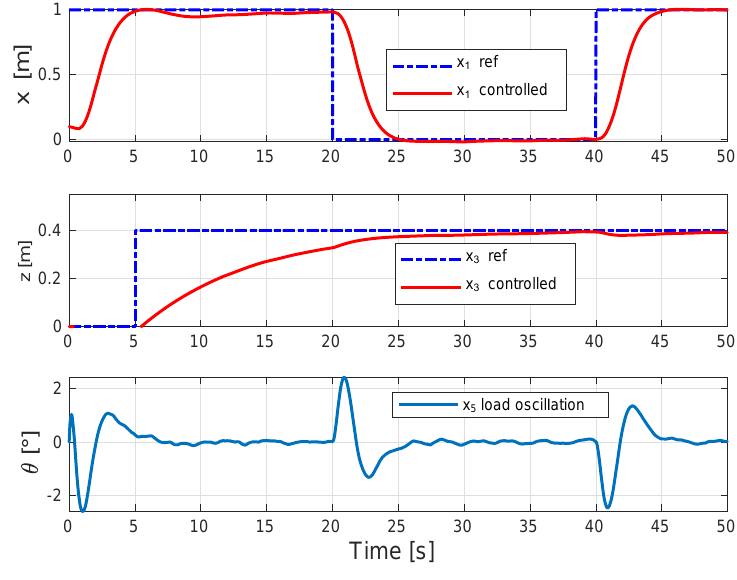
Figure 4. Control performance under an actuator